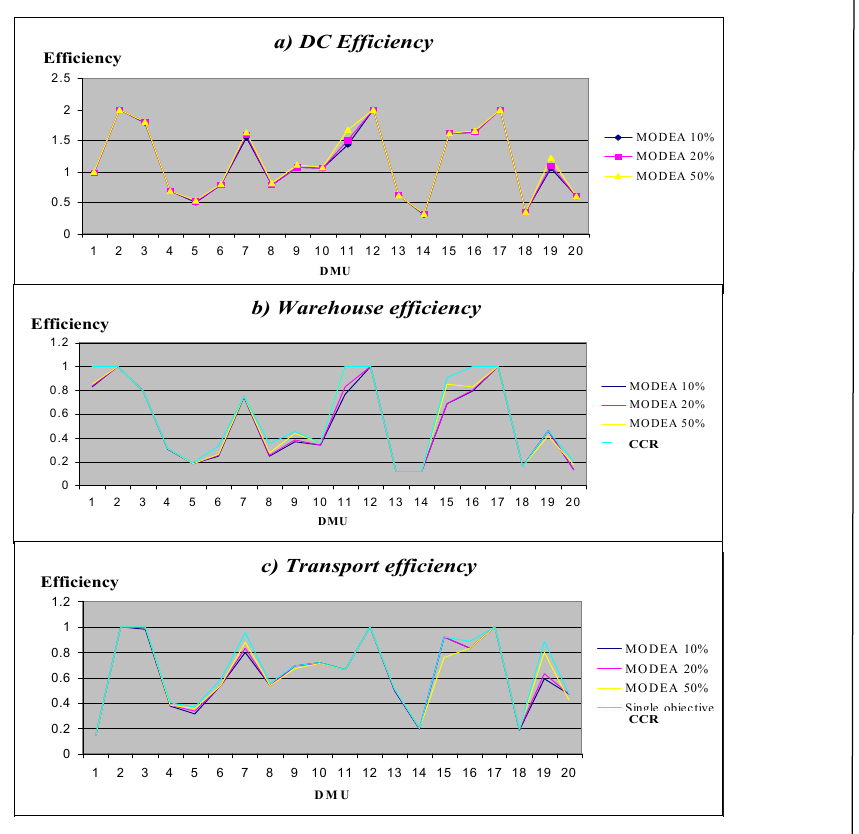
Figure 4 – Efficiency of a DC and its subsystems Slika 4 – Efikasnost DC i osnovnih